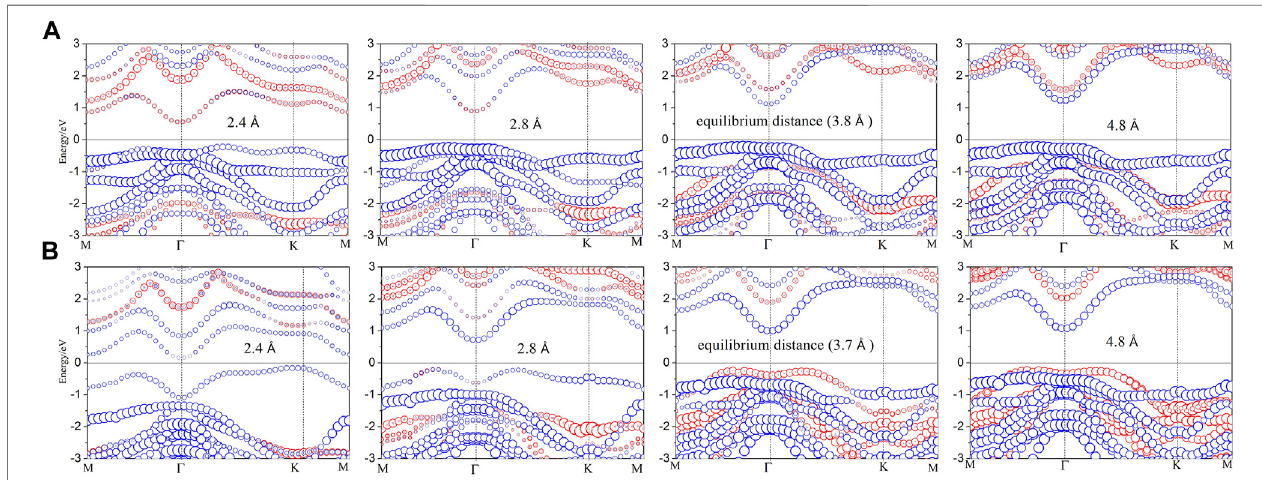
FIGURE 6 | Projected band structures of (A) In 2 Se 3 /InSe (up) and (B) In 2 Se 3 /InSe (down) heterostructures with different interlayer distances. The blue and red circles represent In 2 Se 3 and InSe components, respectively. The Fermi level is set to